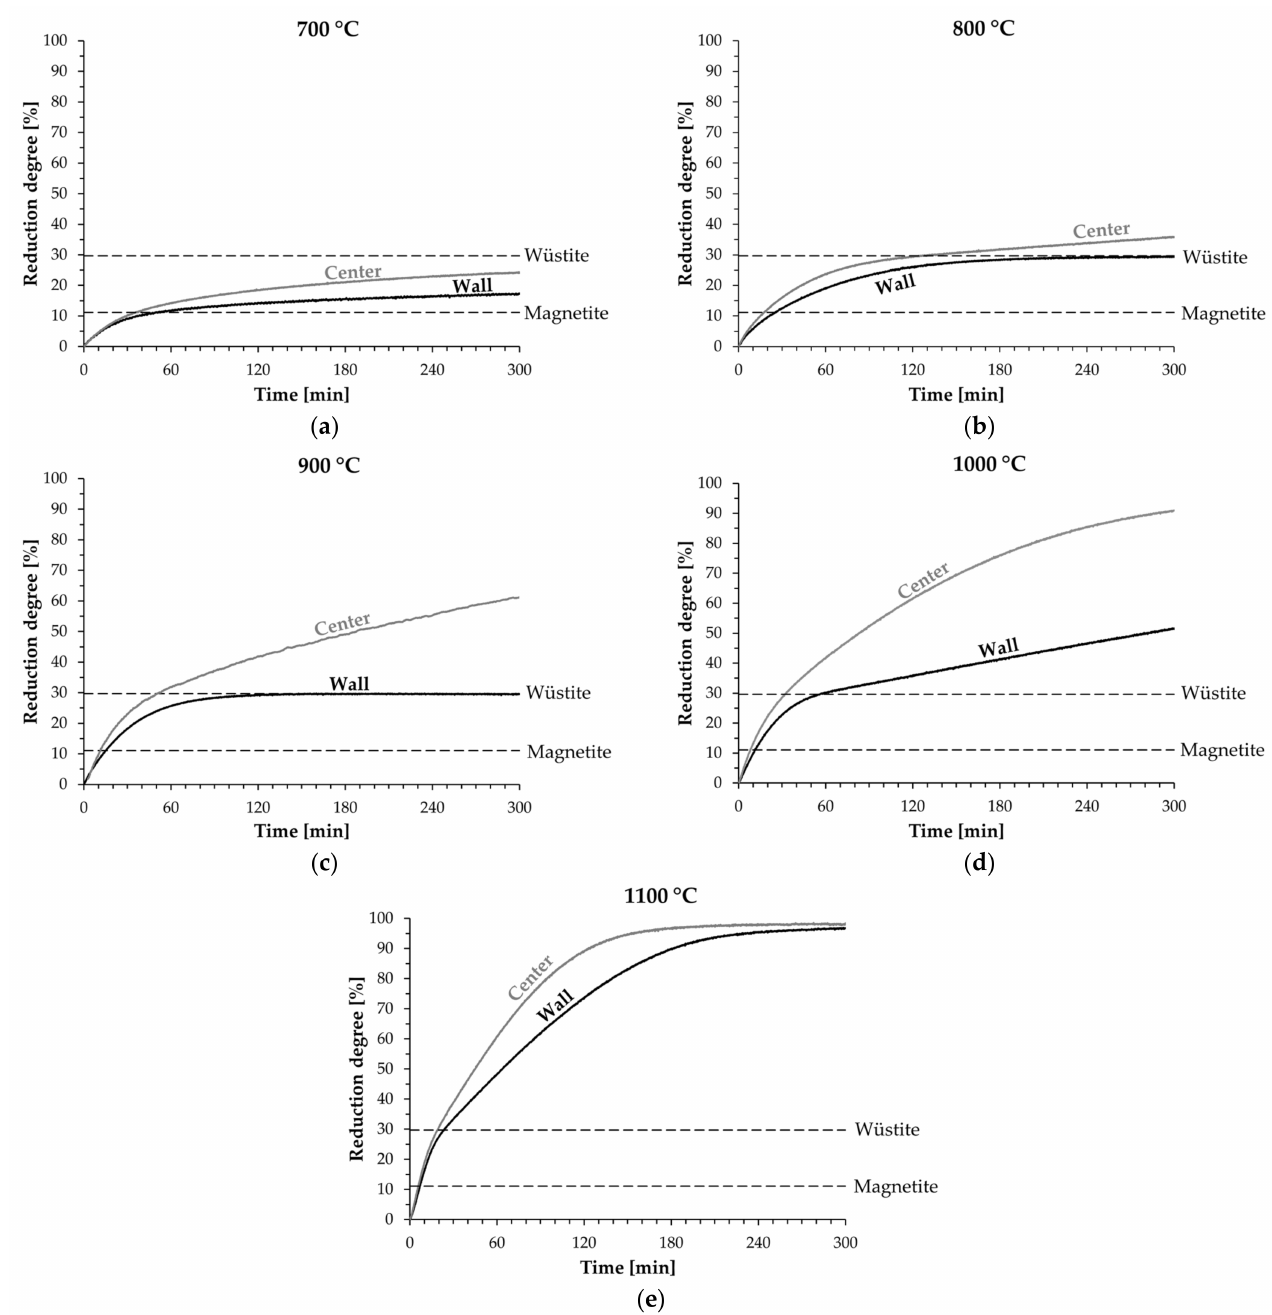
Figure 6. Reduction curves for the pellets reduced isothermally at ( a ) 700, ( b ) 800, ( c ) 900, ( d ) 1000, and ( e ) 1100 ◦ C, simulating the wall and center conditions in a CO-CO 2 -N 2